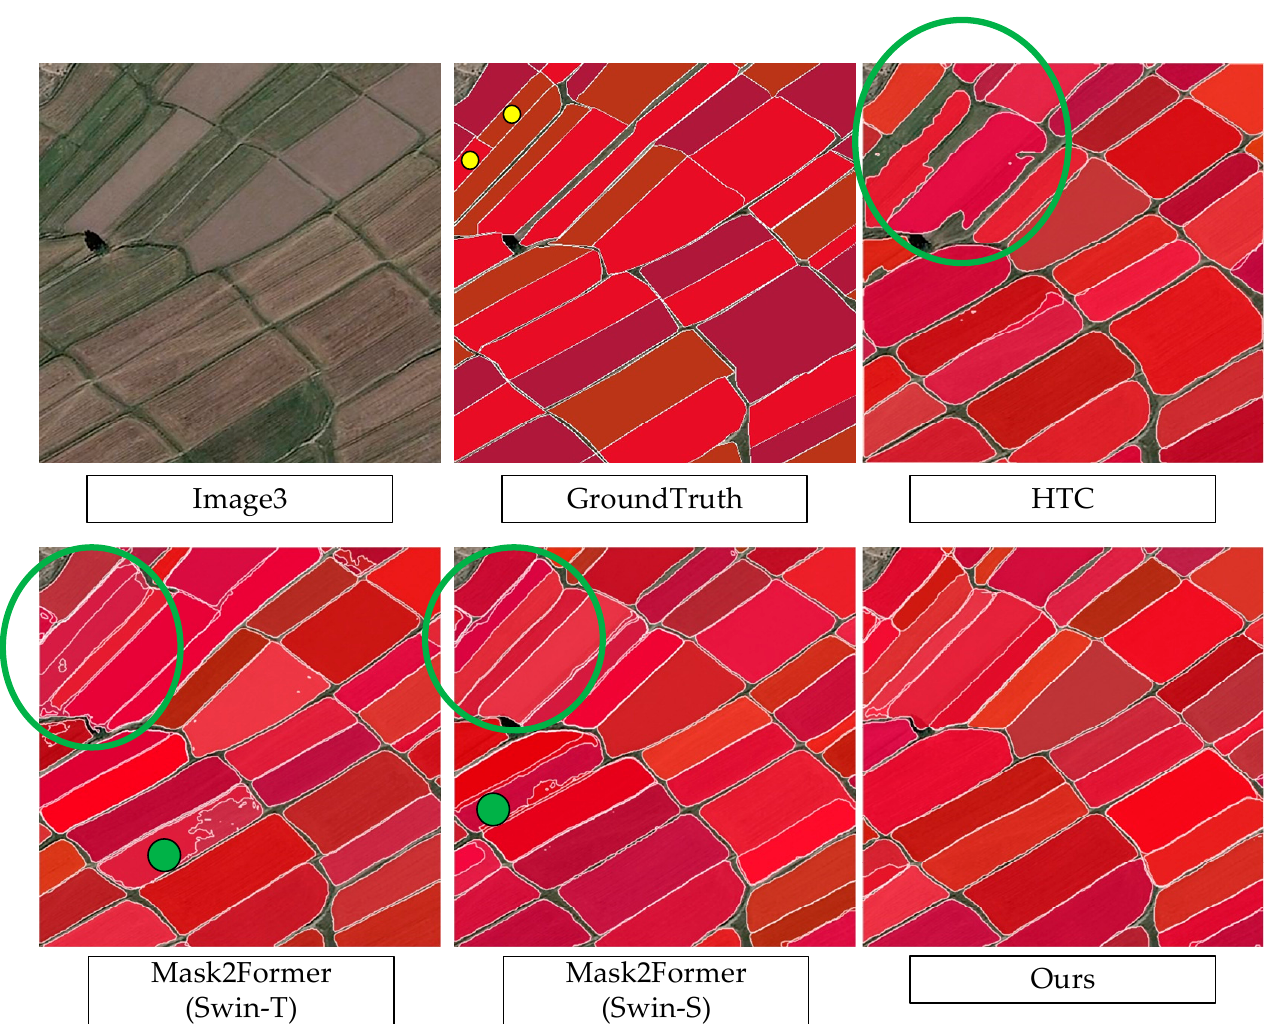
Figure 9. Visual comparison of different models on regular fields of similar size. Green circles highlight areas of poor extraction. Yellow circles highlight areas of small-scale fields in groundtruth.